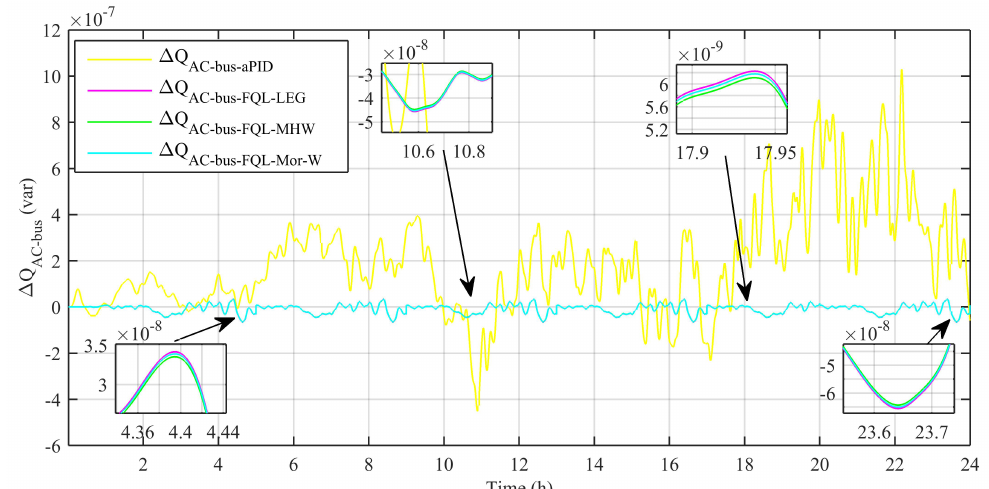
Figure 12. ∆ P AC evolution.